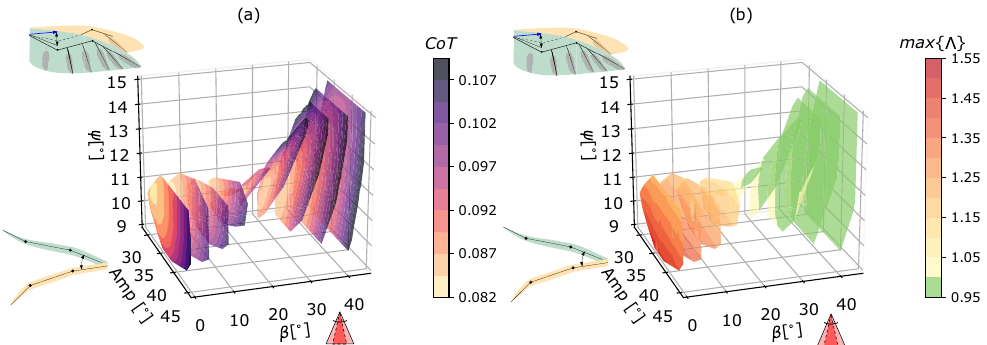
Figure 3. Locus of the steady and level solutions in the gait parameter space. Coloured surfaces are representing slices of this locus, at every 5 ◦ of tail opening. ( a ) Cost of Transport. ( b ) Stability indicator captured via the largest Floquet multiplier. Unstable limit cycles are represented with different shades of yellow-to-red, and stables ones are in green; the transition appears around β = 25 ◦ (Color figure online).